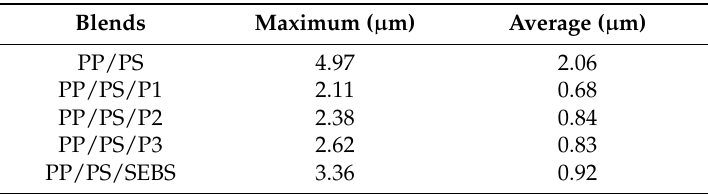
Table 2. Equal area circle diameter of the dispersed phase in the PP/PS blends compatibilized by using 2 wt.% of the compatibilizer.